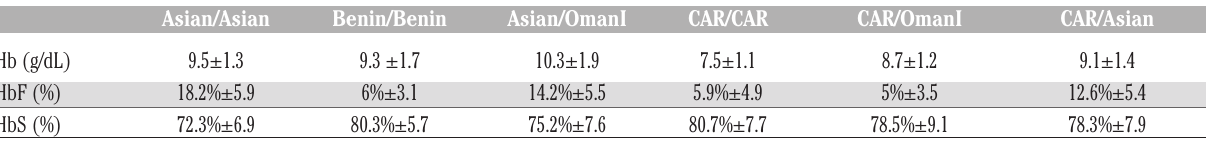
Table 4. Summary of hematological data (average) for each